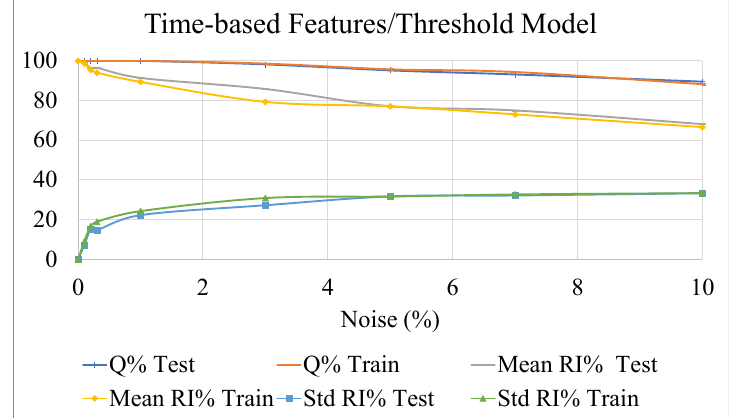
Figure 9. The behavior of the threshold algorithm for postural status detection, as a function of different levels of noise added to the dataset. Results for indexes (3), (13) and (14) calculated for reliability index (4) are shown.